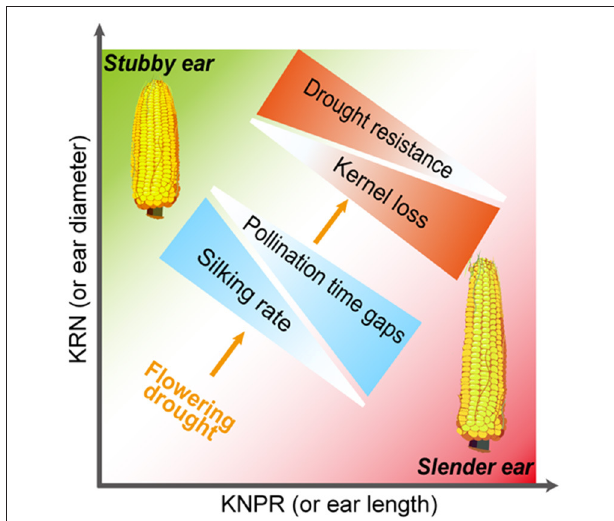
FIGURE 9 | Hypothetic model demonstrating an ear architecture to ameliorate the yield losses induced by asynchronous silking rate and pollination time gaps. With similar numbers of silk and grain in well-watered, those ears with stubby architecture (more KRN but less KNPR) possess faster silking rate and likely less pollination time gaps than did those with slender architecture (less KRN but more KNPR), leading to less kernel losses of the stubby ears when exposing to flowering drought. These results suggest that the stubby ears are more resistant to drought compared with those slender ears. KRN, kernel row number; KNPR, kernel number per row.